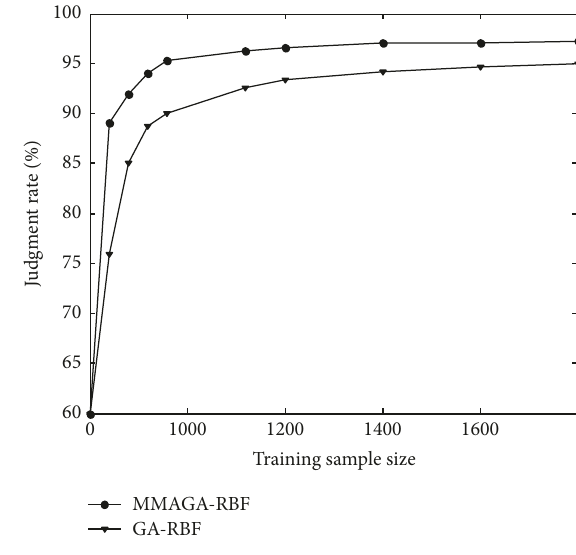
Figure 9: Curve of judgment rate.